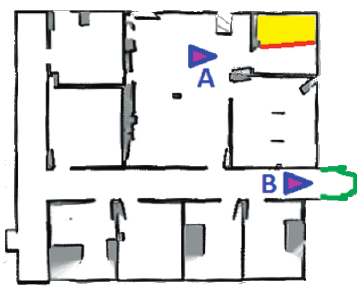
Figure 1. Re-exploration caused by restricted communication. [20]. The yellow portion of the map is only known by robot B. Thus, robot A goes to re-explore the region beyond the red